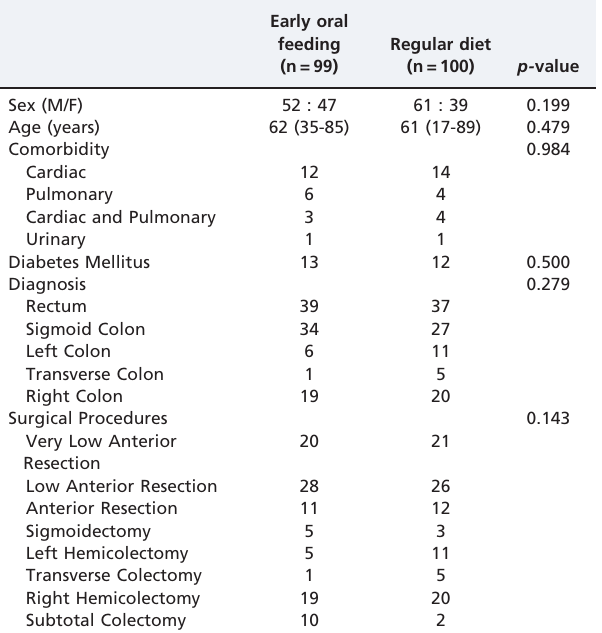
Table 1 - The patients’ demographics and baseline data.